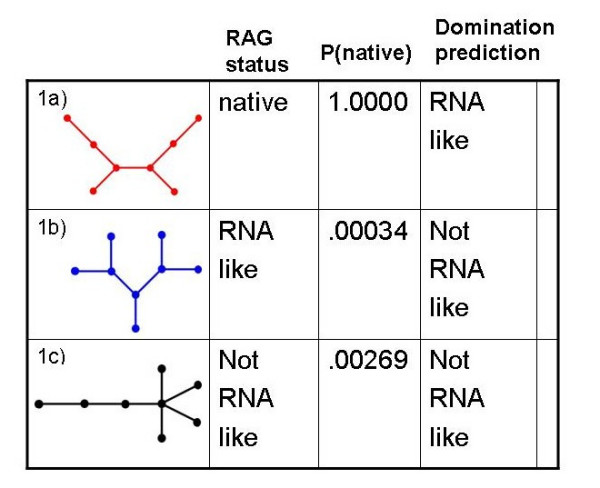
Three trees of order 8 has three trees of order 8, Figure 1a, 1b and figure 1c.